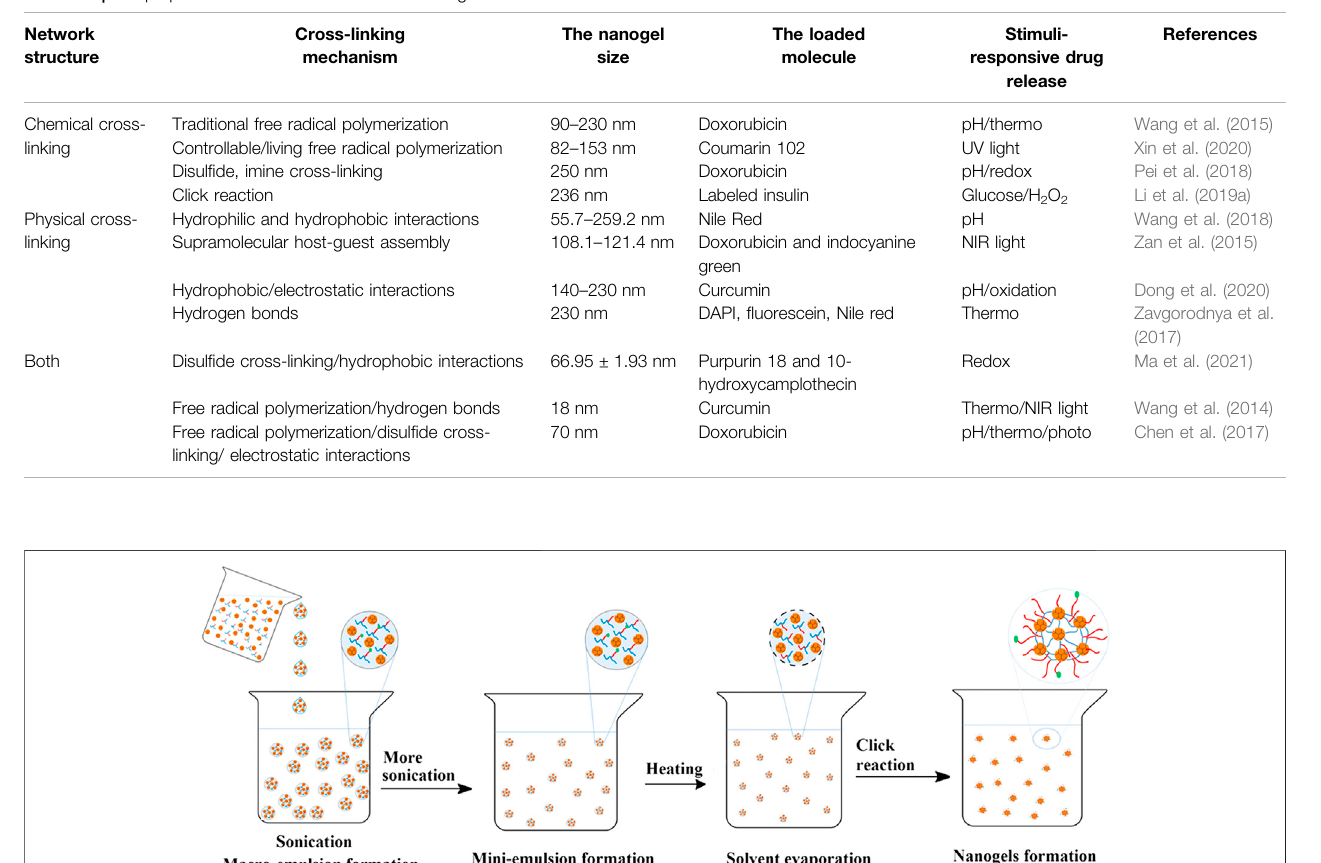
TABLE 1 | The preparation mechanisms and relevant drug release behaviors of NG-DDS.